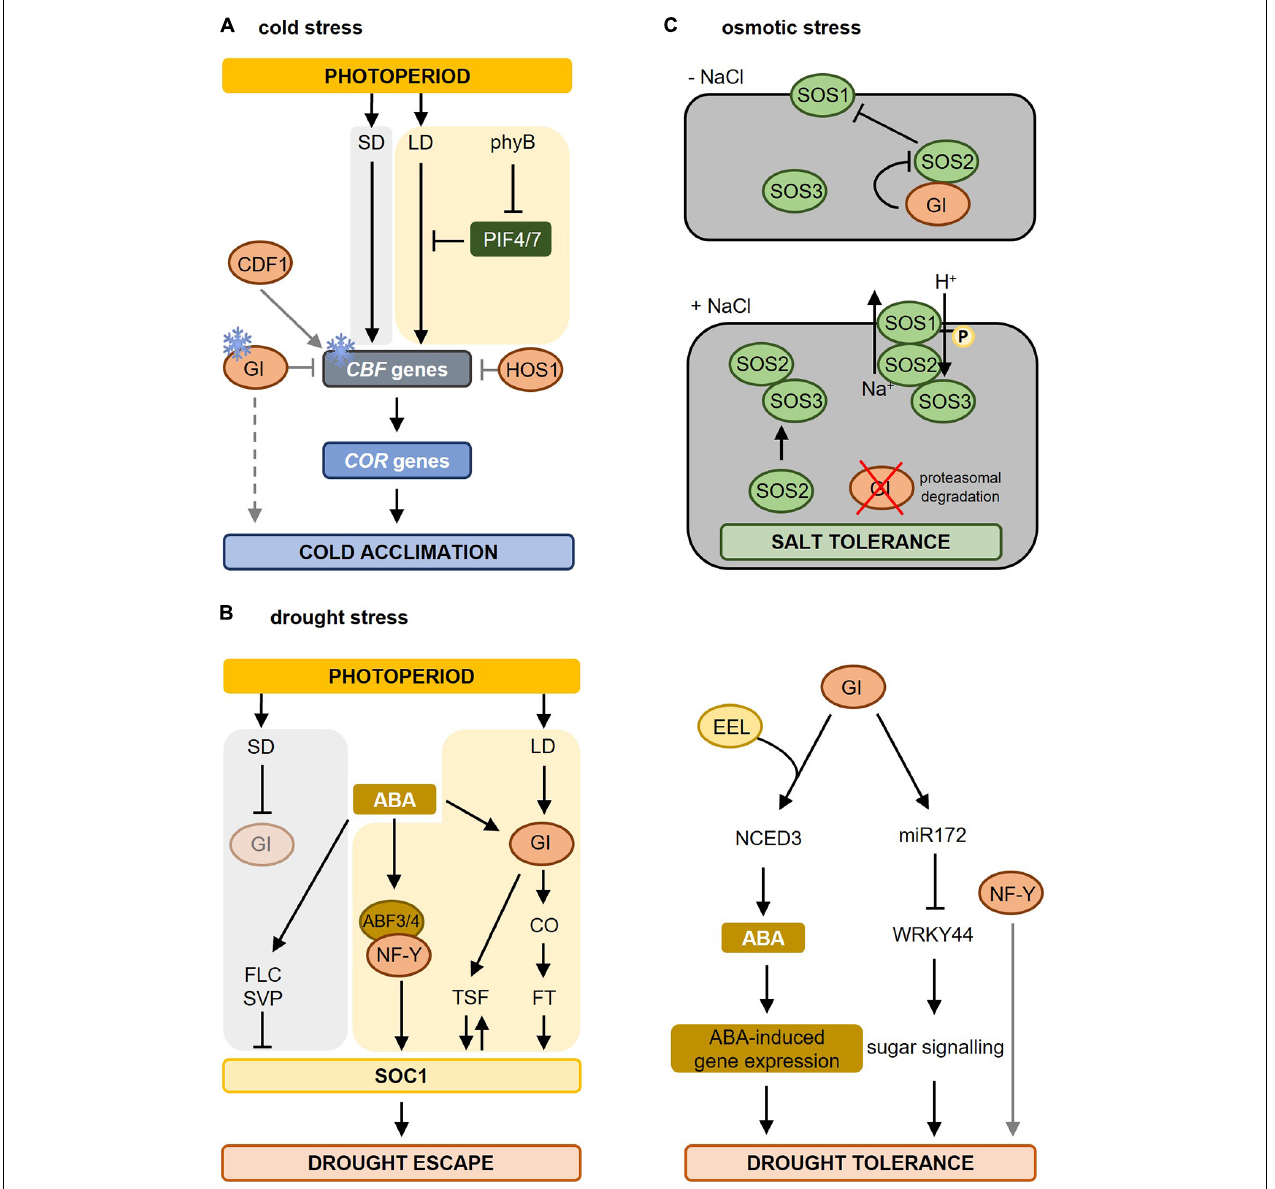
FIGURE 3 | Molecular mechanisms involved in photoperiod-dependent responses to cold, drought, and osmotic stress. (A) During cold stress (indicated by the ice crystal), CBF gene expression is upregulated and induces the expression of COR genes resulting in cold acclimation. Under short-day (SD) conditions, CBF genes are strongly induced causing cold acclimation. Under warmer long-day (LD) conditions, PIF4 and PIF7 , which are under the control of phyB, are higher expressed resulting in an inhibition of CBF gene expression. As days shorten, e.g., during autumn, this repression falls away resulting in cold acclimation. GI is also induced by colder temperatures and blocks the CBF genes, whereas CDF1 promotes the expression of CBF . GI also promotes freezing tolerance in a CBF-independent manner (dashed line). In addition, HOS1, another photoperiod-dependent flowering-inducing component inhibits CBF gene expression thereby blocking cold acclimation. Figure adapted from Roeber et al. (2021). (B) Drought stress results in biosynthesis of abscisic acid (ABA) leading to ABA-dependent gene regulation causing drought escape (left) and drought tolerance (right). The increased ABA levels promote earlier flowering (drought escape, left part) under LD but not under SD conditions. Under LD conditions, GI is activated and activates the expression of florigen genes ( TSF and FT via CO) triggering the activation of SOC1 and inducing flowering. SOC1 in turn contributes to TSF upregulation boosting SOC1 activity. ABA also induces the expression and activity of ABF3 and ABF4. ABF3/4, together with their interacting partner, the NF-Y complex, binds to the SOC1 promoter and promotes its expression to accelerate flowering during drought escape. Under SD conditions, delay of flowering occurs during drought stress due to enhanced activity of repressors like FLC and SVP on SOC1 transcription. Under these SD conditions, GI is not activated (pale circle). Adapted from Riboni et al. (2013, 2016) and Hwang et al. (2019). In the drought tolerance signaling pathway (right part), GI forms a complex with EEL (ENHANCED EM LEVEL) thereby upregulating the diurnal expression of NCED3 ( NINE-CIS-EPOXYCAROTENOID DIOXYGENASE3 ) encoding a rate-limiting enzyme in ABA synthesis. Furthermore, interaction between GI and miR172 results in a reduction of WRKY44 expression promoting sugar signaling and drought tolerance. Besides GI, also NUCLEAR FACTOR-Y (NF-Y) promotes drought tolerance. (C) In the absence of salt stress (-NaCl) GI